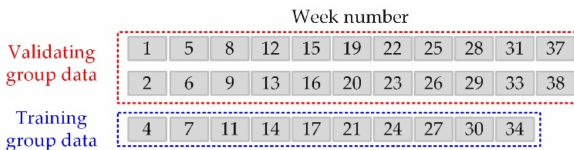
Figure 10. Schematic diagram of the validating dataset and training